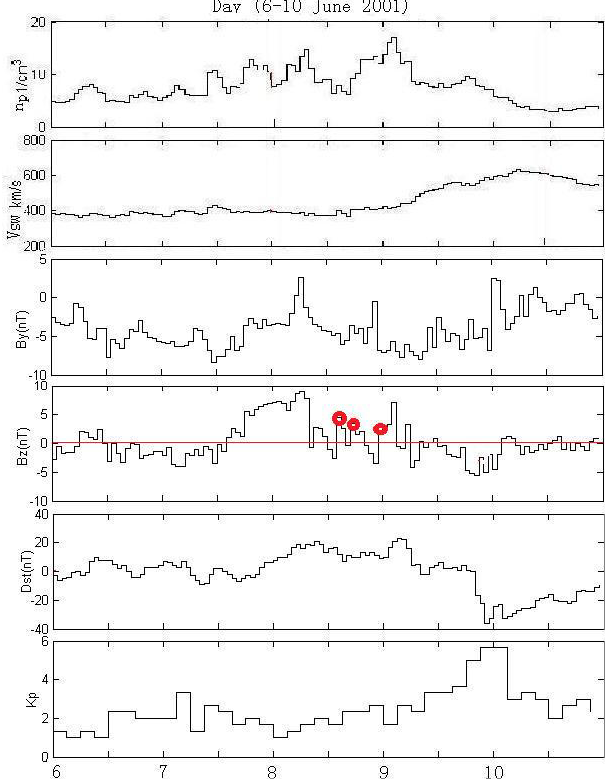
Figure 2. Input parameters of the TPM model. The variation of the By and Bz component of the IMF, the Dst index, and Kp index, on 6–10 June 2001, is a typical substorm